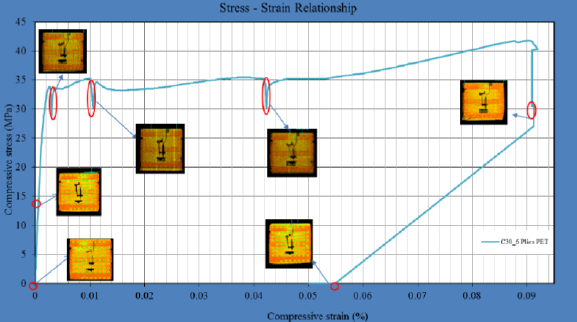
Figure 5. The relationship between compressive stress and strain for C30 reference sample with 7 scanning phase The deformation capability of samples can be seen on Figure 4